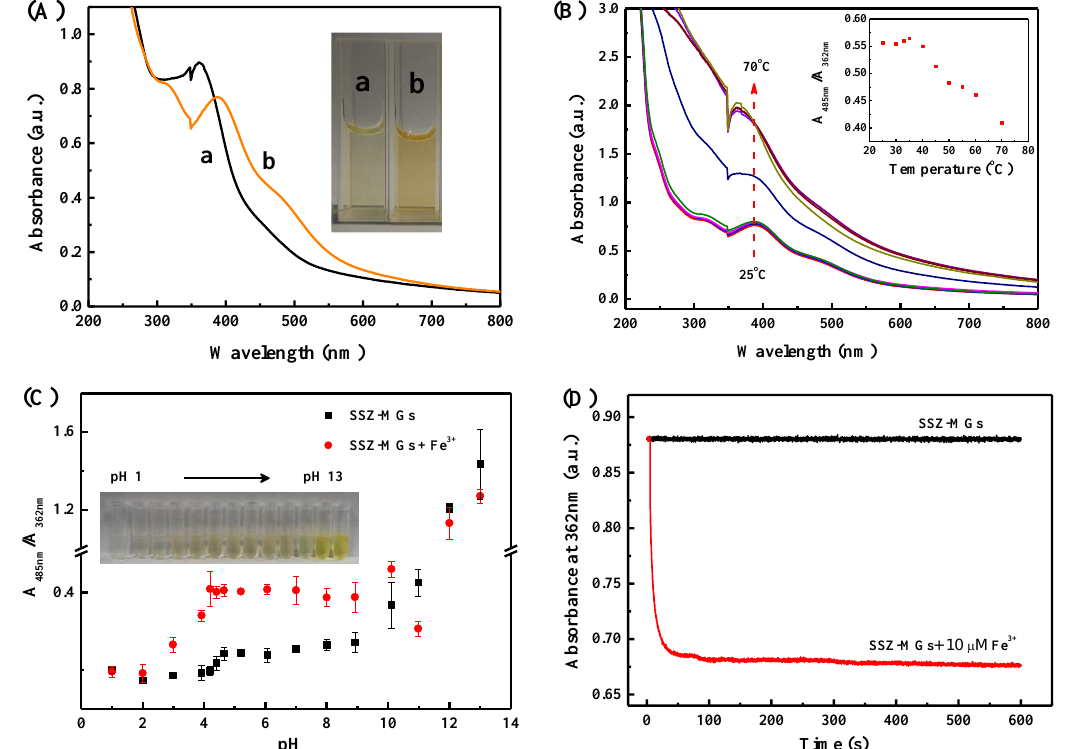
Figure 3. ( A ) UV-vis absorption spectrum of SSZ-MG aqueous suspensions (0.196 mg/mL) without (a) and with (b) the presence of 10 μM Fe 3+ ions at 25 °C and pH of 5.6. The inset is the corresponding photographs of SSZ-MG aqueous suspensions without (a) and with (b) the presence of 10 μM Fe 3+ ions. ( B ) UV-vis absorption spectra of SSZ-MG aqueous suspensions (0.196 mg/mL) with the presence of 10 μM Fe 3+ ions at various temperatures and pH of 5.6. Inset shows the corresponding A 485nm /A 362nm ratios. ( C ) The A 485nm /A 362nm ratios of SSZ-MG aqueous suspensions (0.099 mg/mL ) with and without the presence of 50 μM Fe 3+ ions at 25 °C and various pH values. Inset of ( C ) shows the corresponding photographs of SSZ-MG aqueous suspensions with the presence of 50 μM Fe 3+ ions. ( D ) Plot of absorption intensity at 362 nm of SSZ-MG aqueous suspensions (0.196 mg/mL) as a function of time after adding 10 μM Fe 3+ ions at 25 °C and pH of 5.6.